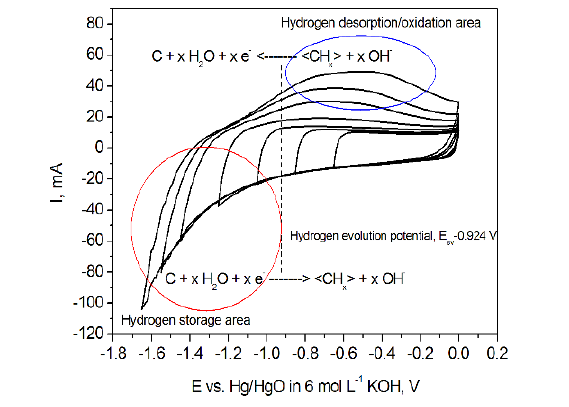
Figure 2 . Voltammetry cycling of carbon electrode (AC) in 6 mol L -1 KOH at 5mV s -1 scan rate with a gradual shift into negative values of potential